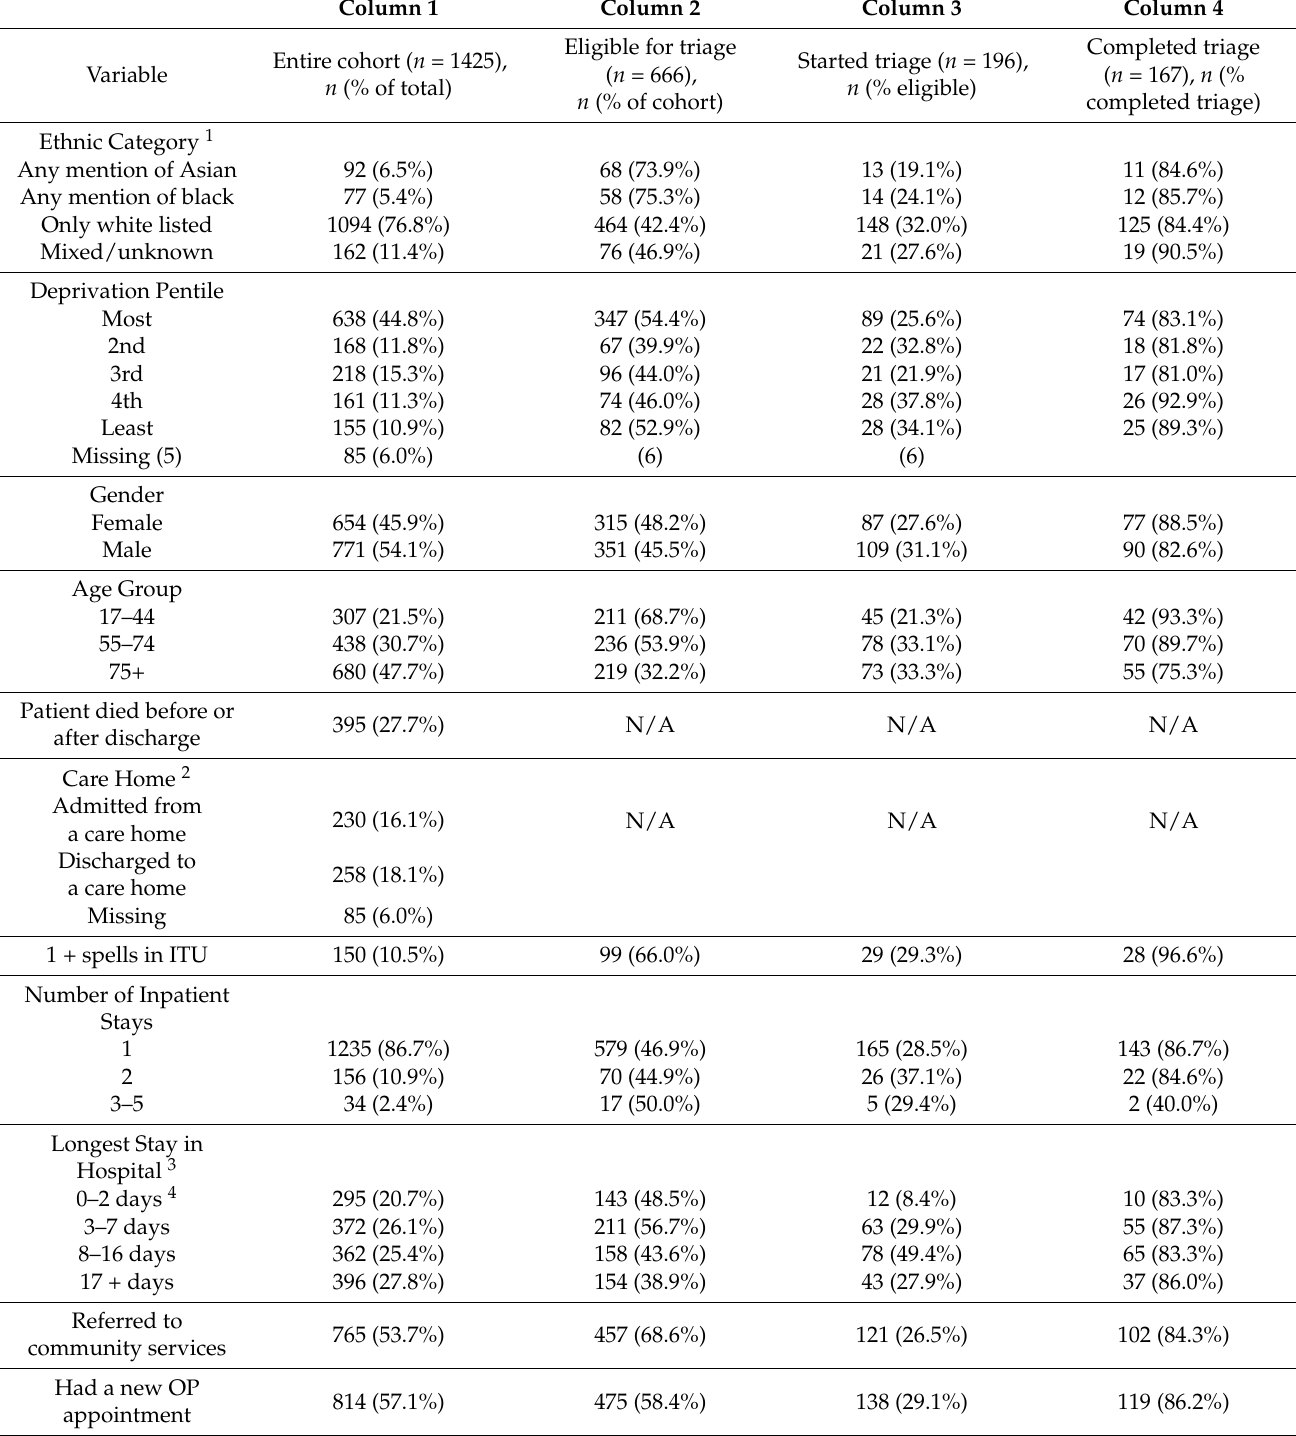
Table 1. Demographics of the 1411 patients and each subsequent